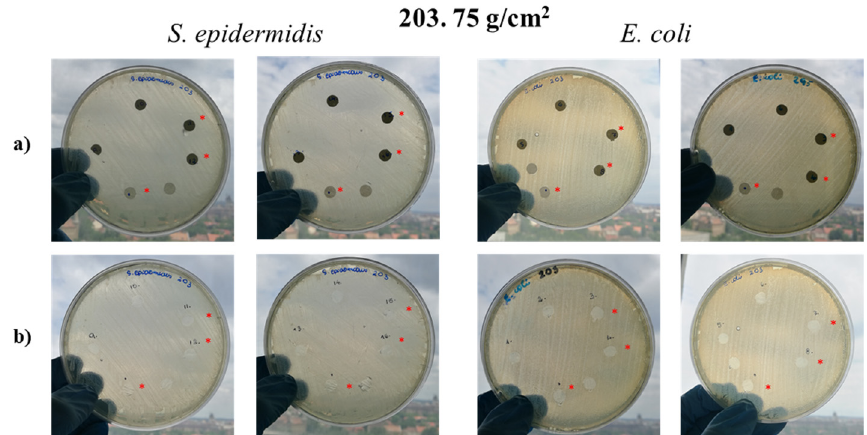
Figure 7. Petri dishes after the first 24 h incubation ( a ) and Petri dishes after removal of specimen discs ( b ). * indicates samples treated with DMSO. discs ( b ). * indicates samples treated with